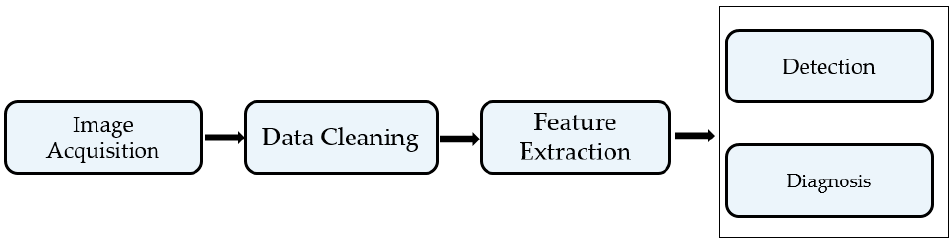
Figure 1. Workflow of a CADx system.